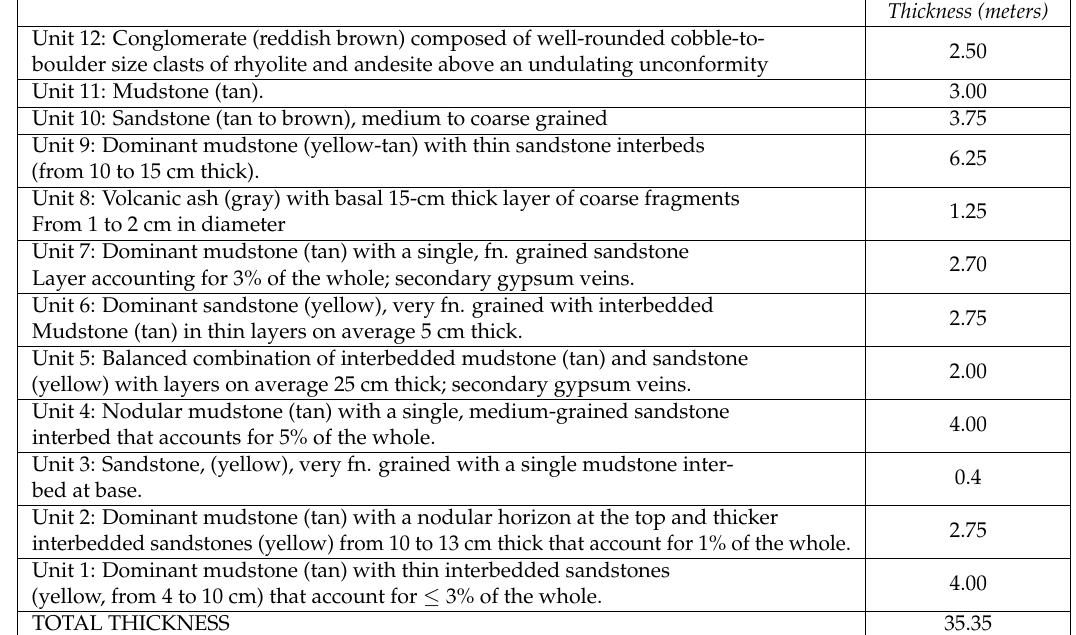
Thickness (meters) 2.50 2.00